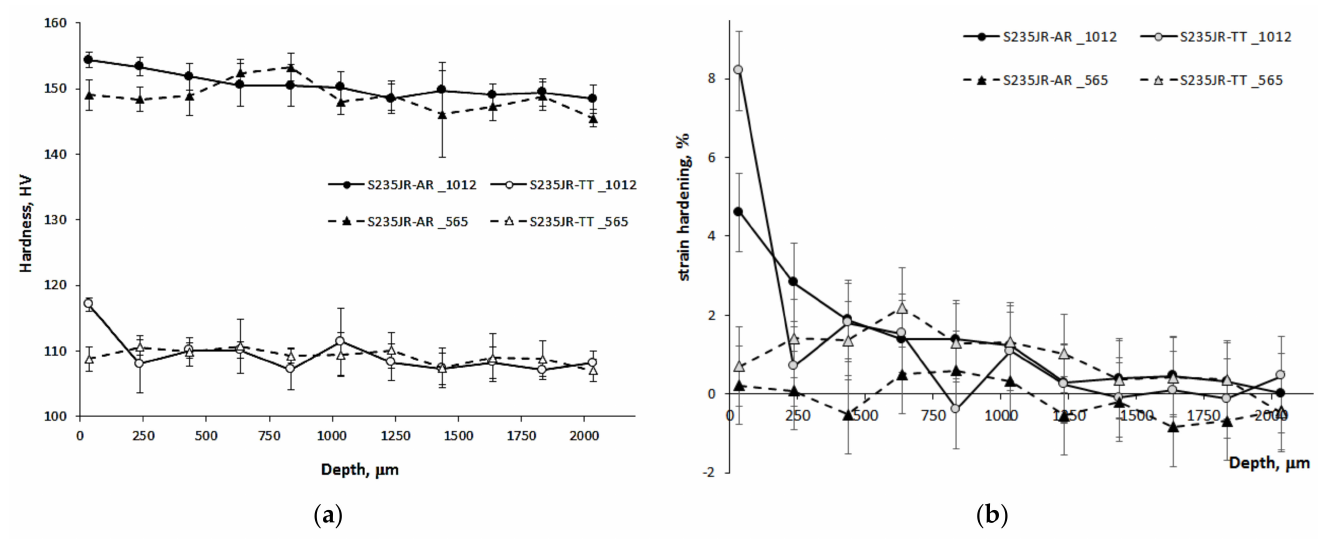
Figure 11. Hardness ( a ) and strain hardening effect ( b ) along the specimen depth caused by